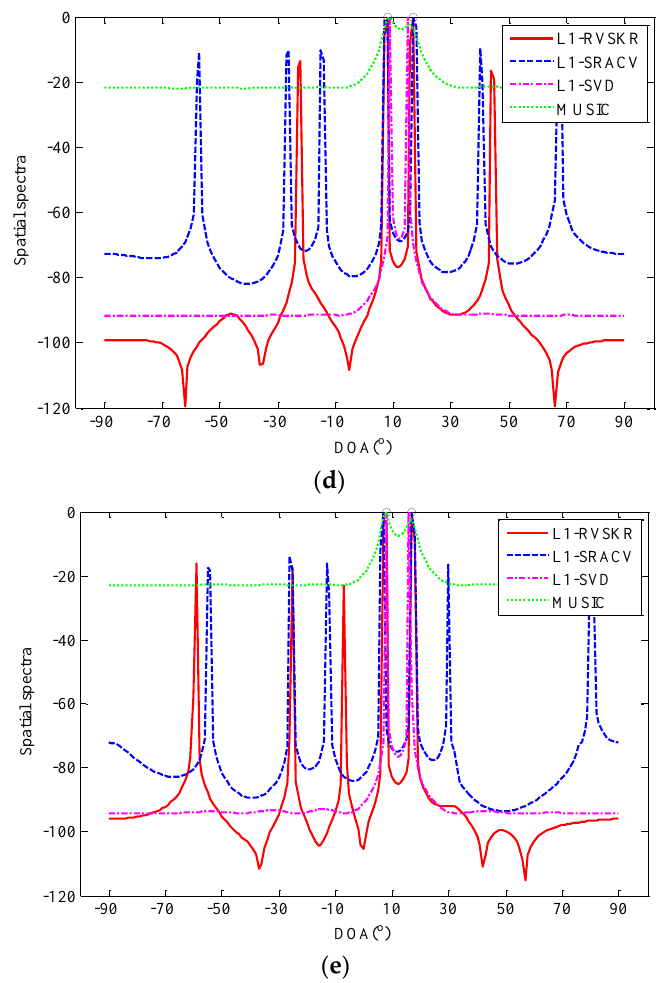
Figure 2. The spatial spectra for two signals with the number of sensors 8 M and the number of snapshots 300 L : ( a ) SNR = −8 dB; ( b ) SNR = −6 dB; ( c ) SNR = −4 dB; ( d ) SNR = −2 dB; ( e ) SNR = 0 dB. DOA: direction of arrival; RVSKR: real-valued sparse DOA estimation algorithm